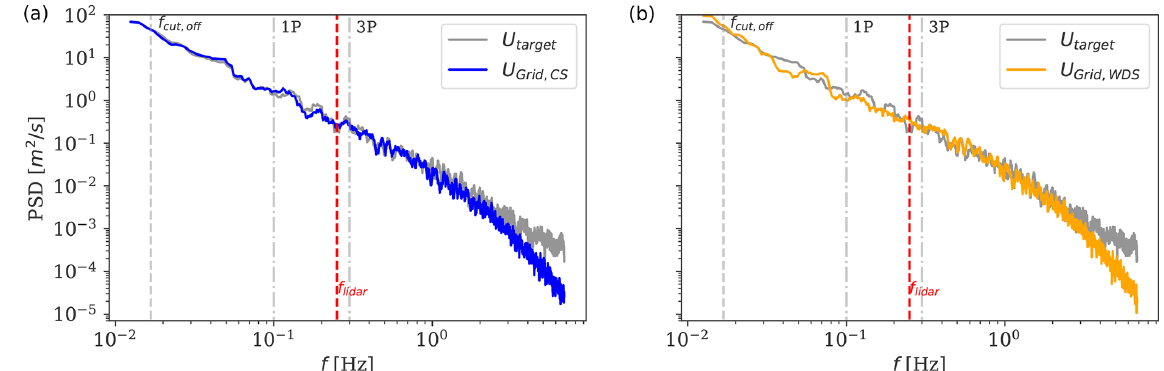
Figure 7. Comparisons of the power spectra density (PSD) of the target u -velocity component measured at hub height with predictions obtained by the CS field (a) and the WDS field (b) . The dominant frequency of the wake meandering f cut,off ≈ 0 . 016Hz, the rotational frequency of the rotor and its harmonics (1P ≈ 0.1Hz and 3P ≈ 0.3Hz), and the Nyquist frequency of the lidar ( ≈ 0 . 25Hz) are shown (see text for more